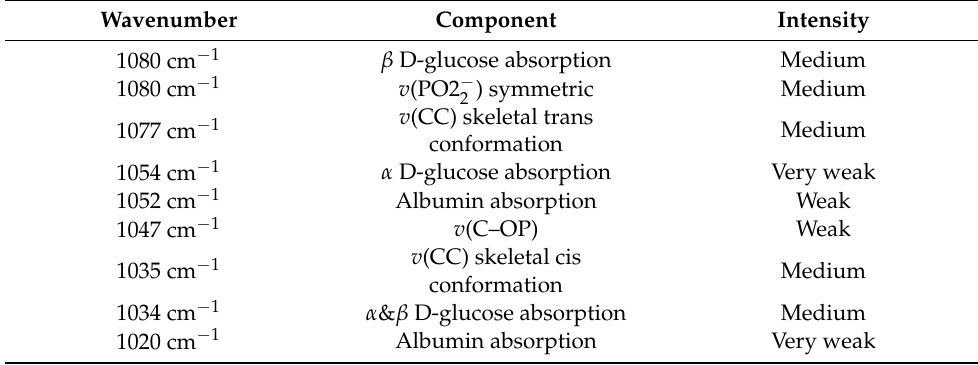
Figure 1. Overview of various techniques and active research areas for in vivo and in vitro glucose monitoring. Table 2. Vibrational absorption frequencies for some blood components of the skin